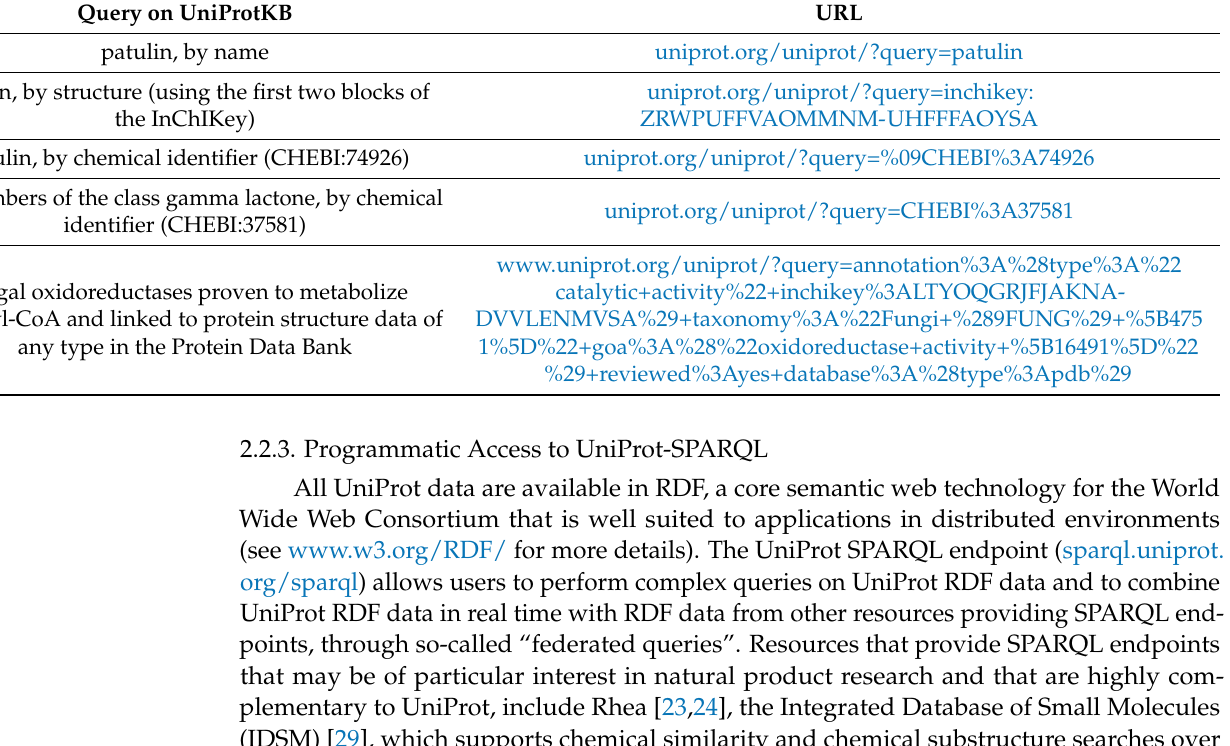
Table 1. Examples of queries on www.uniprot.org and the corresponding URLs (that can be bookmarked for future reference). Query on UniProtKB URL